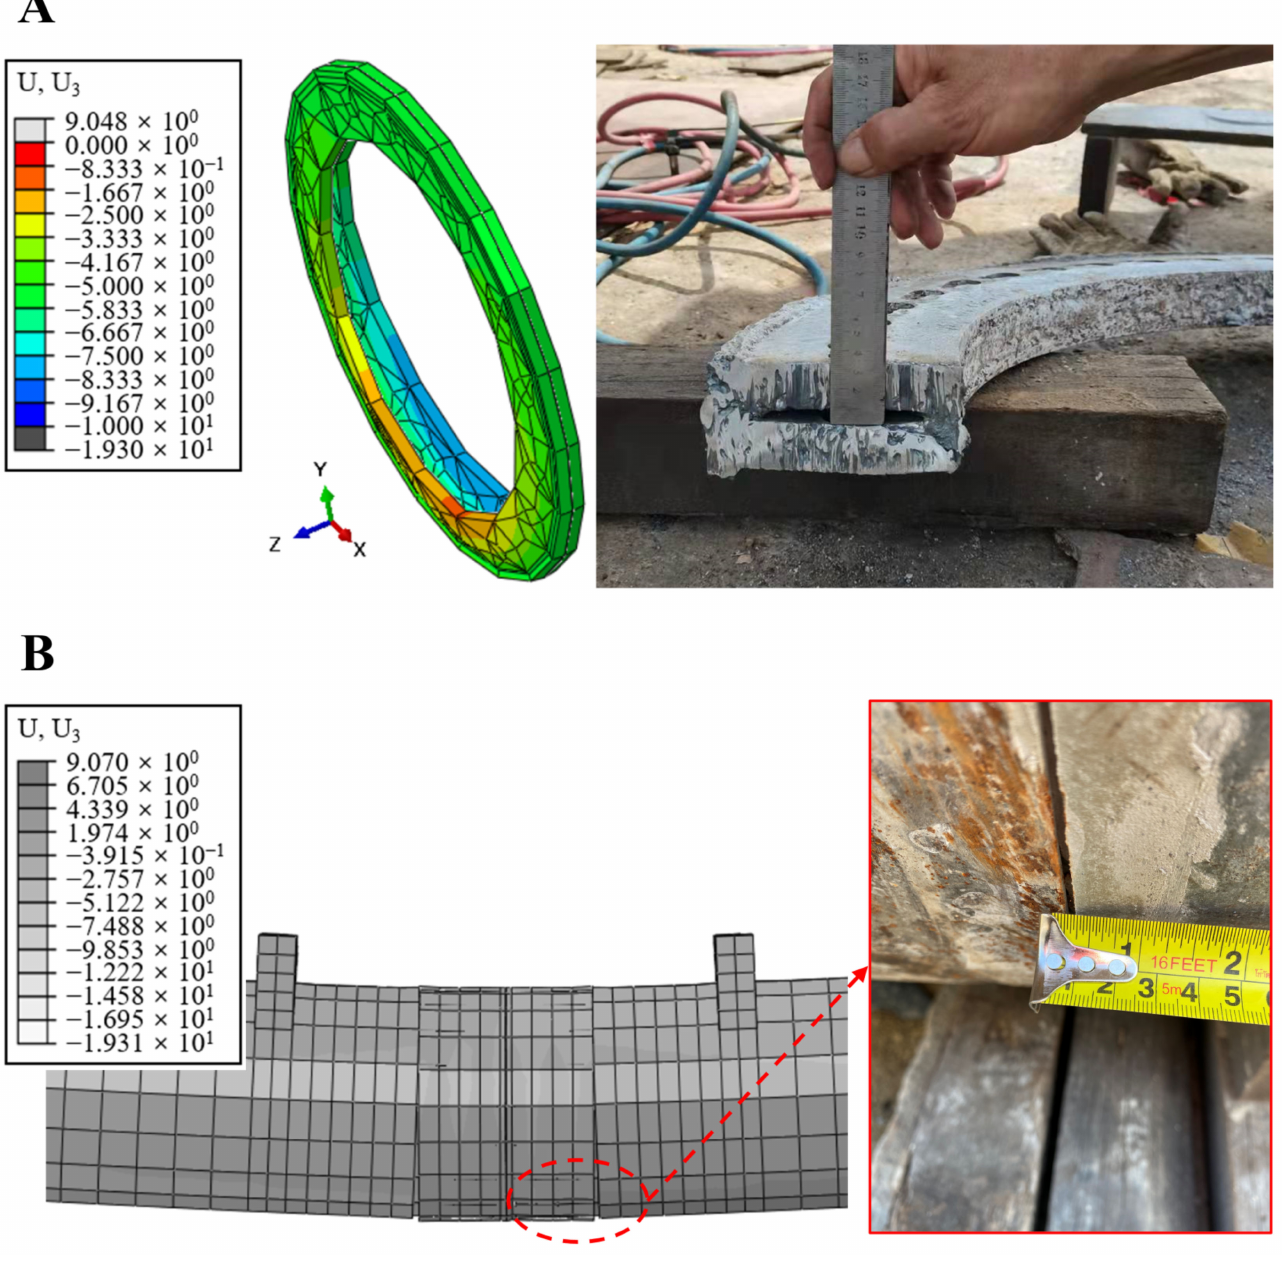
Figure 12. Deformation of pipe pile joint (display enlarged by 10 times, unit: mm): ( A ) end plate; ( B ) pile